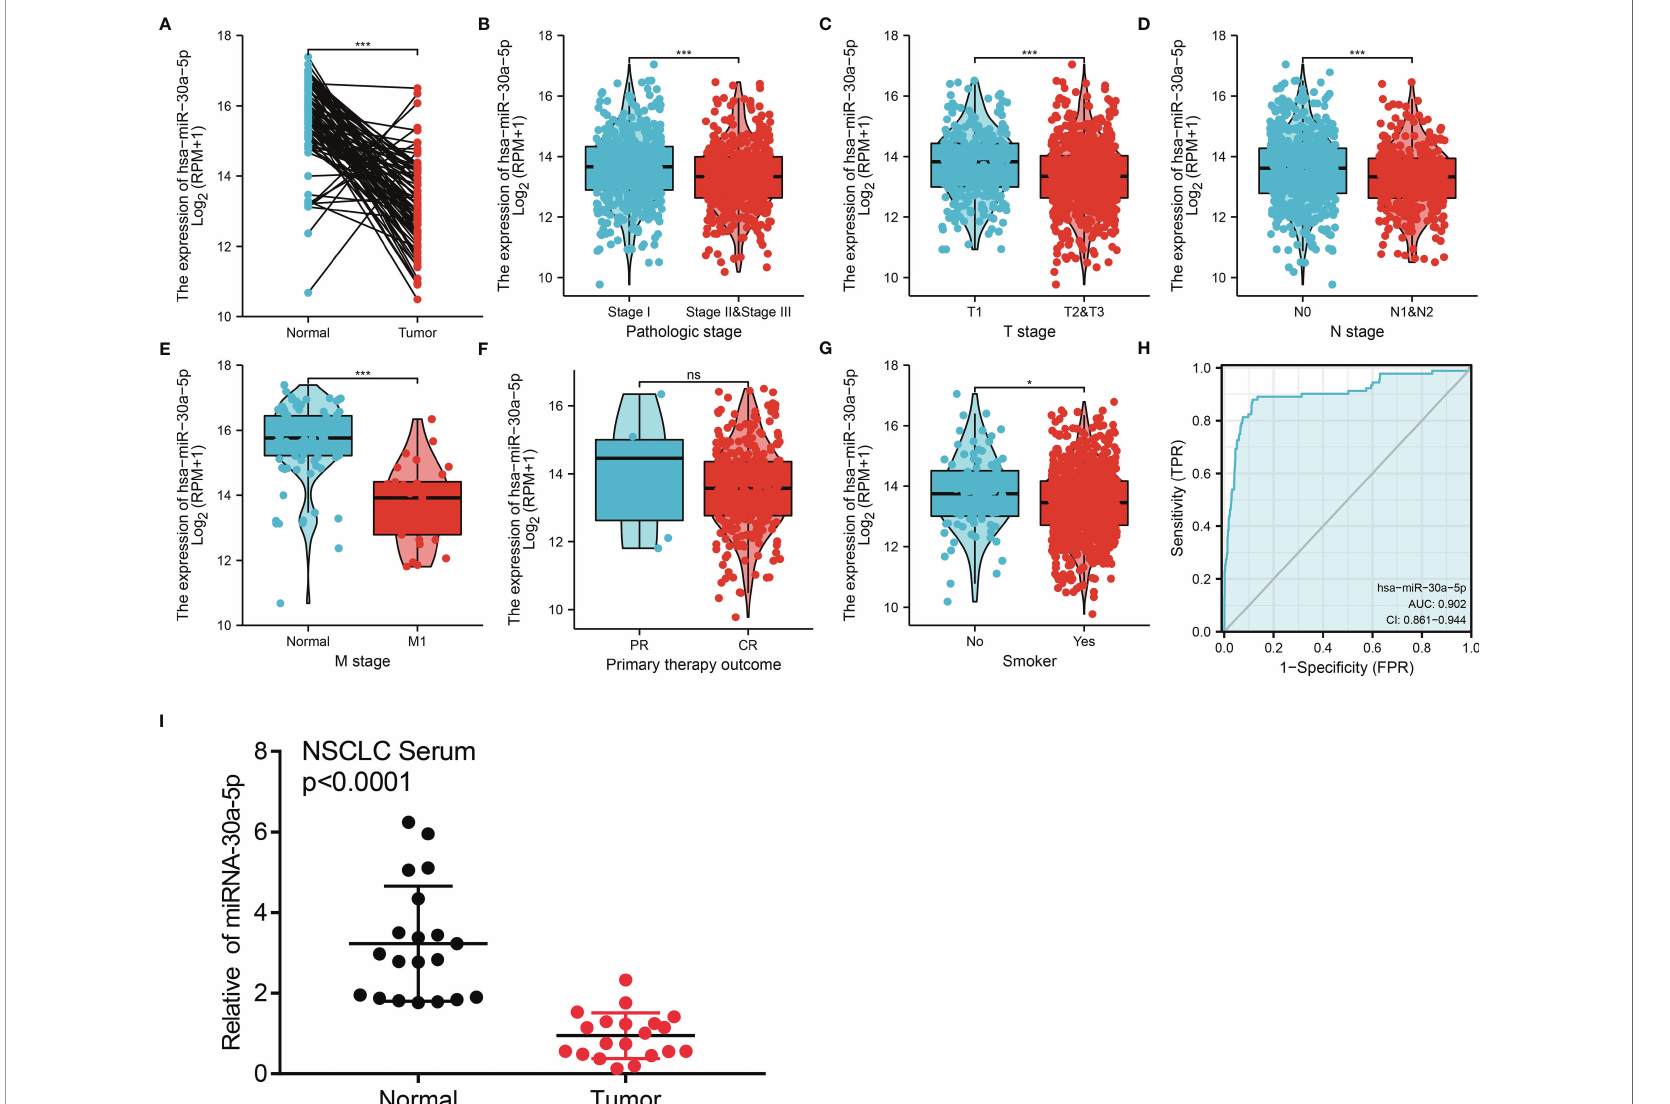
FIGURE 5 | miRNA-30a-5p was down-regulated in LUAD. (A) MiRNA-30a-5p was down-regulated in lung cancer based on TCGA-LAUD dataset. (B – G) Correlation between miRNA-30a-5p and clinicpathologic features, including the pathology stage, TNM stage, smoker, and therapy outcome in LUAD. (H) ROC curve analysis of miRNA-30a-5p showed an AUC value of 0.902 in LUAD. (I) miRNA-30a-5p was down-regulated in peripheral blood serum of LUAD analysed using qRT-PCR assay. *P < 0.05, ***P < 0.001. CR, complete response; PR, partial response; SD, stable disease; PD, progressive disease. NS: p